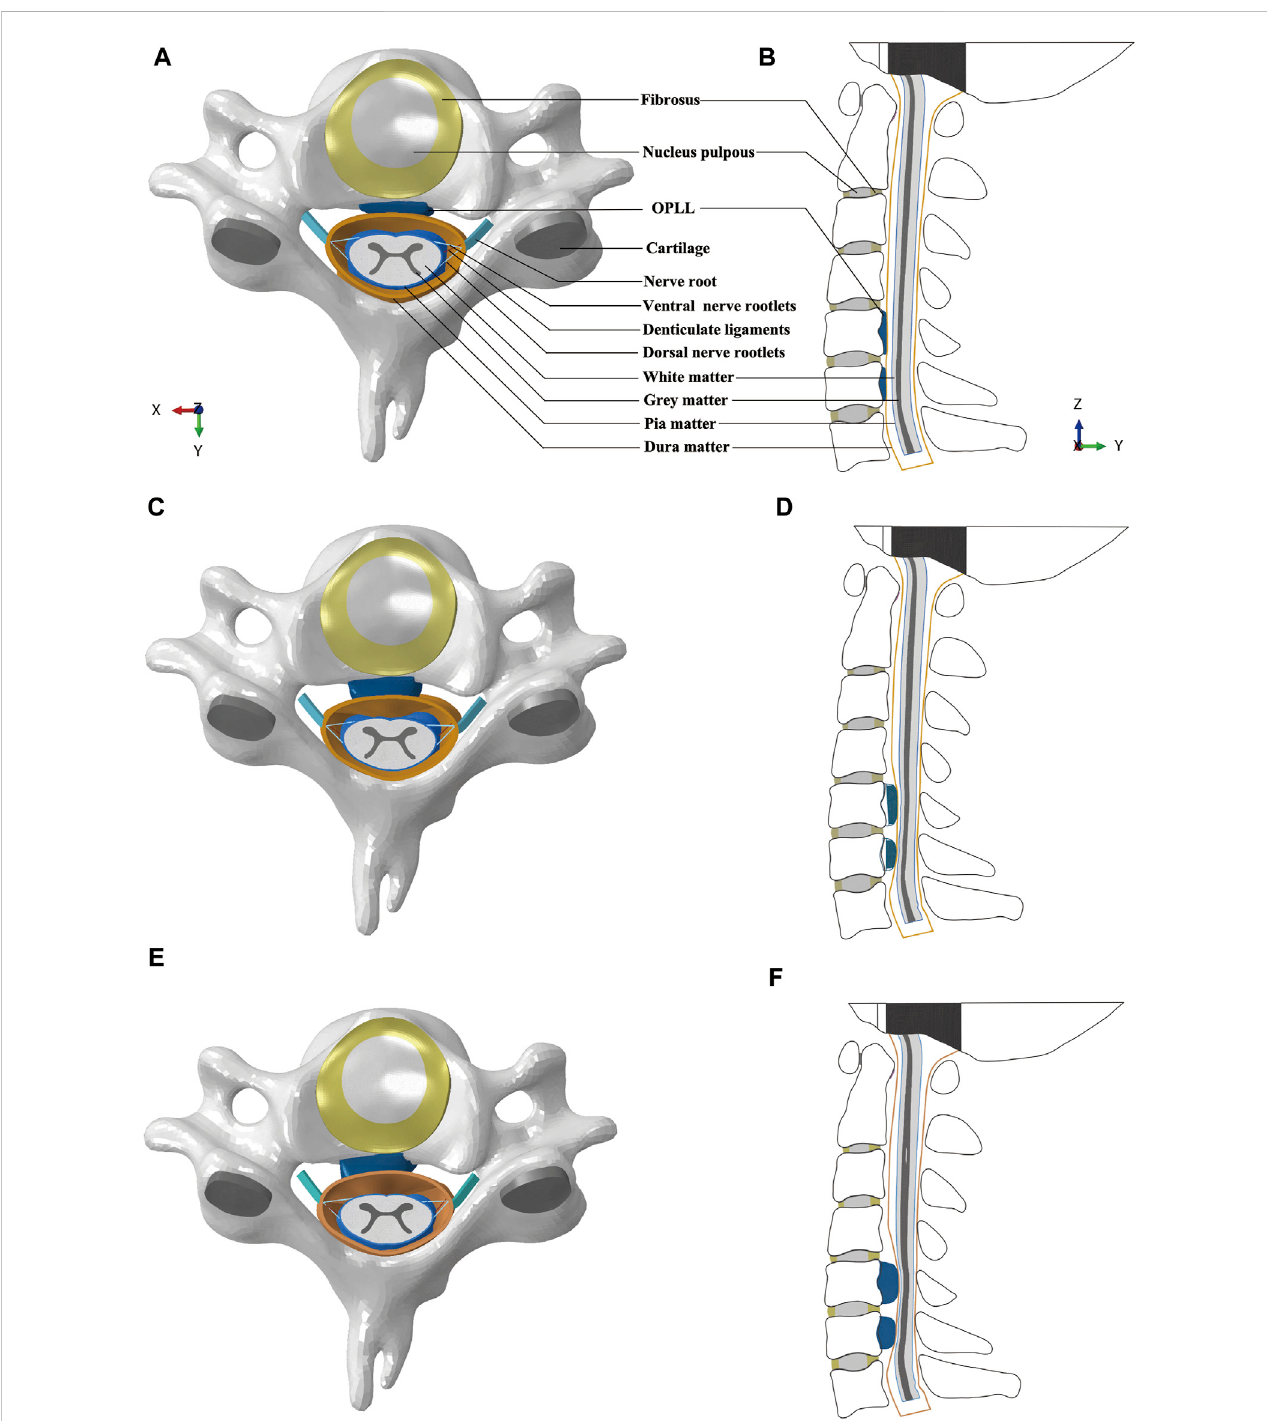
FIGURE 1 Intact FE models of cervicalspine and spinal cord complex: (A) Transverseview ofC5 with mild OPLL. (B) Sagittal view of theFE model with mild OPLL at theC5andC6segments. (C) TransverseviewofC5withmoderateOPLL. (D) SagittalviewoftheFEmodelwithmoderateOPLLattheC5andC6segments. (E) TransverseviewofC5withsevereOPLL. (F) SagittalviewoftheFEmodelwithsevereOPLLattheC5andC6segments.(FE, fi niteelement;OPLL,ossi fi cationof the posterior longitudinal